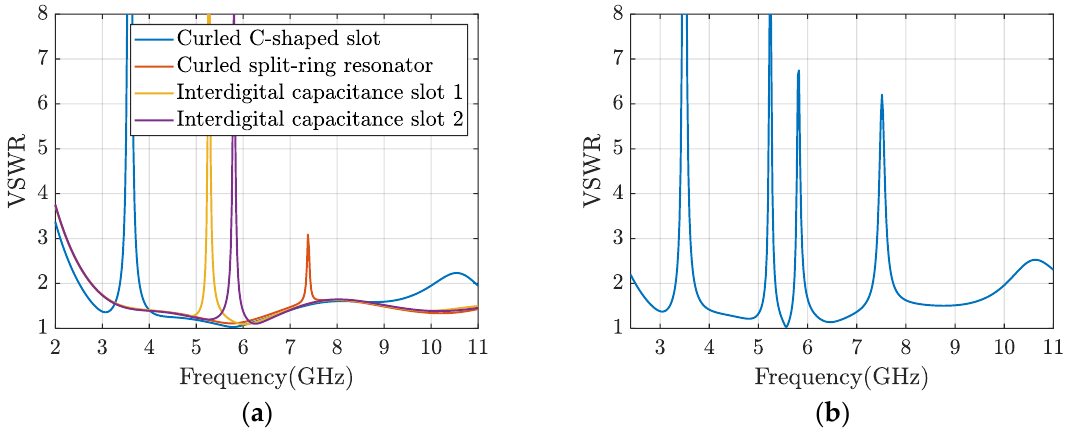
Figure 5. Simulated VSWR of UWB antennas with ( a ) single band-notched structure and ( b ) all structures.